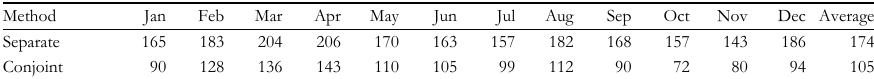
Number of IFUs identified using bias ratio criterion (22) with the conjoint and the separate procedures for level and change – Months of 2004 and